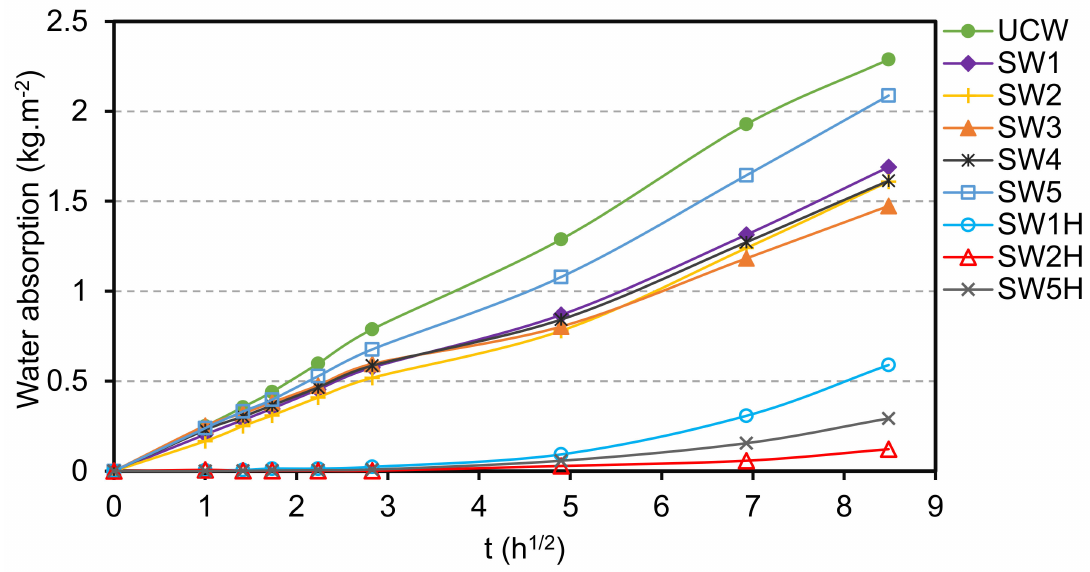
Figure 9. Water absorption curves of the coatings at the surface of wood. UCW is uncoated wood and SW1H, SW2H, and SW5H are SW1, SW2, and SW3 post-treated the hydrophobizing dispersion